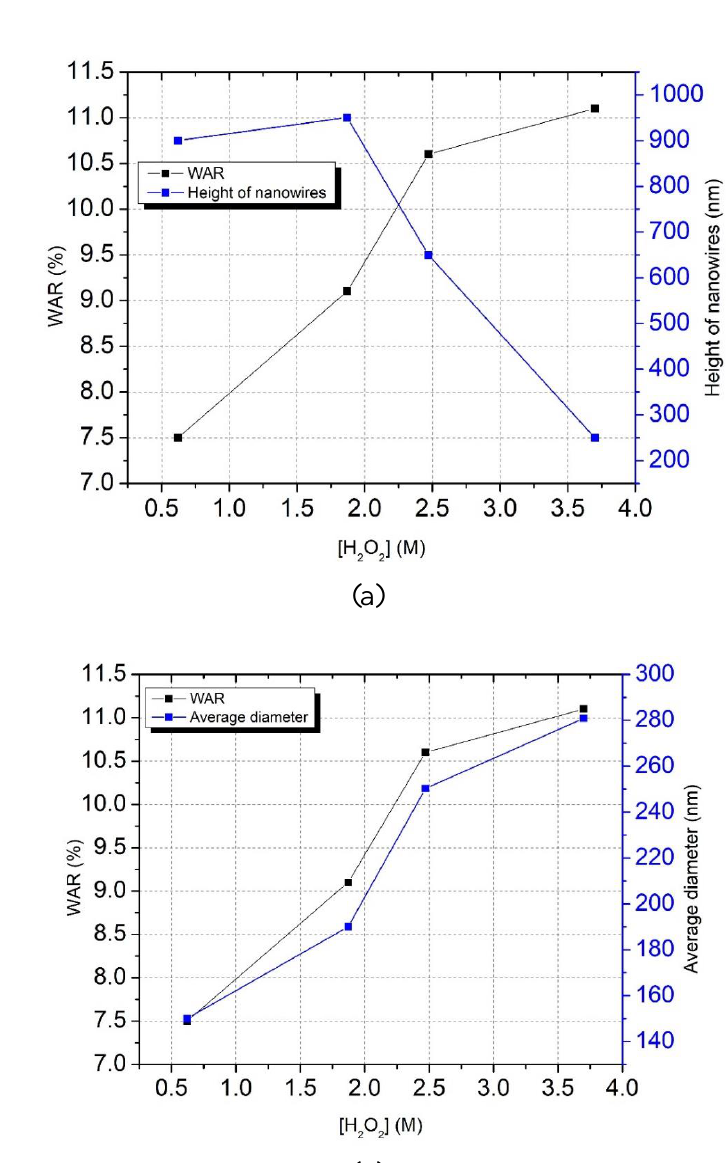
Figure 5: (a) Relationship between WAR and height of b-Si nanowires with different H concentrations (b) Relationship between WAR and average diameter of b-Si nanowires with